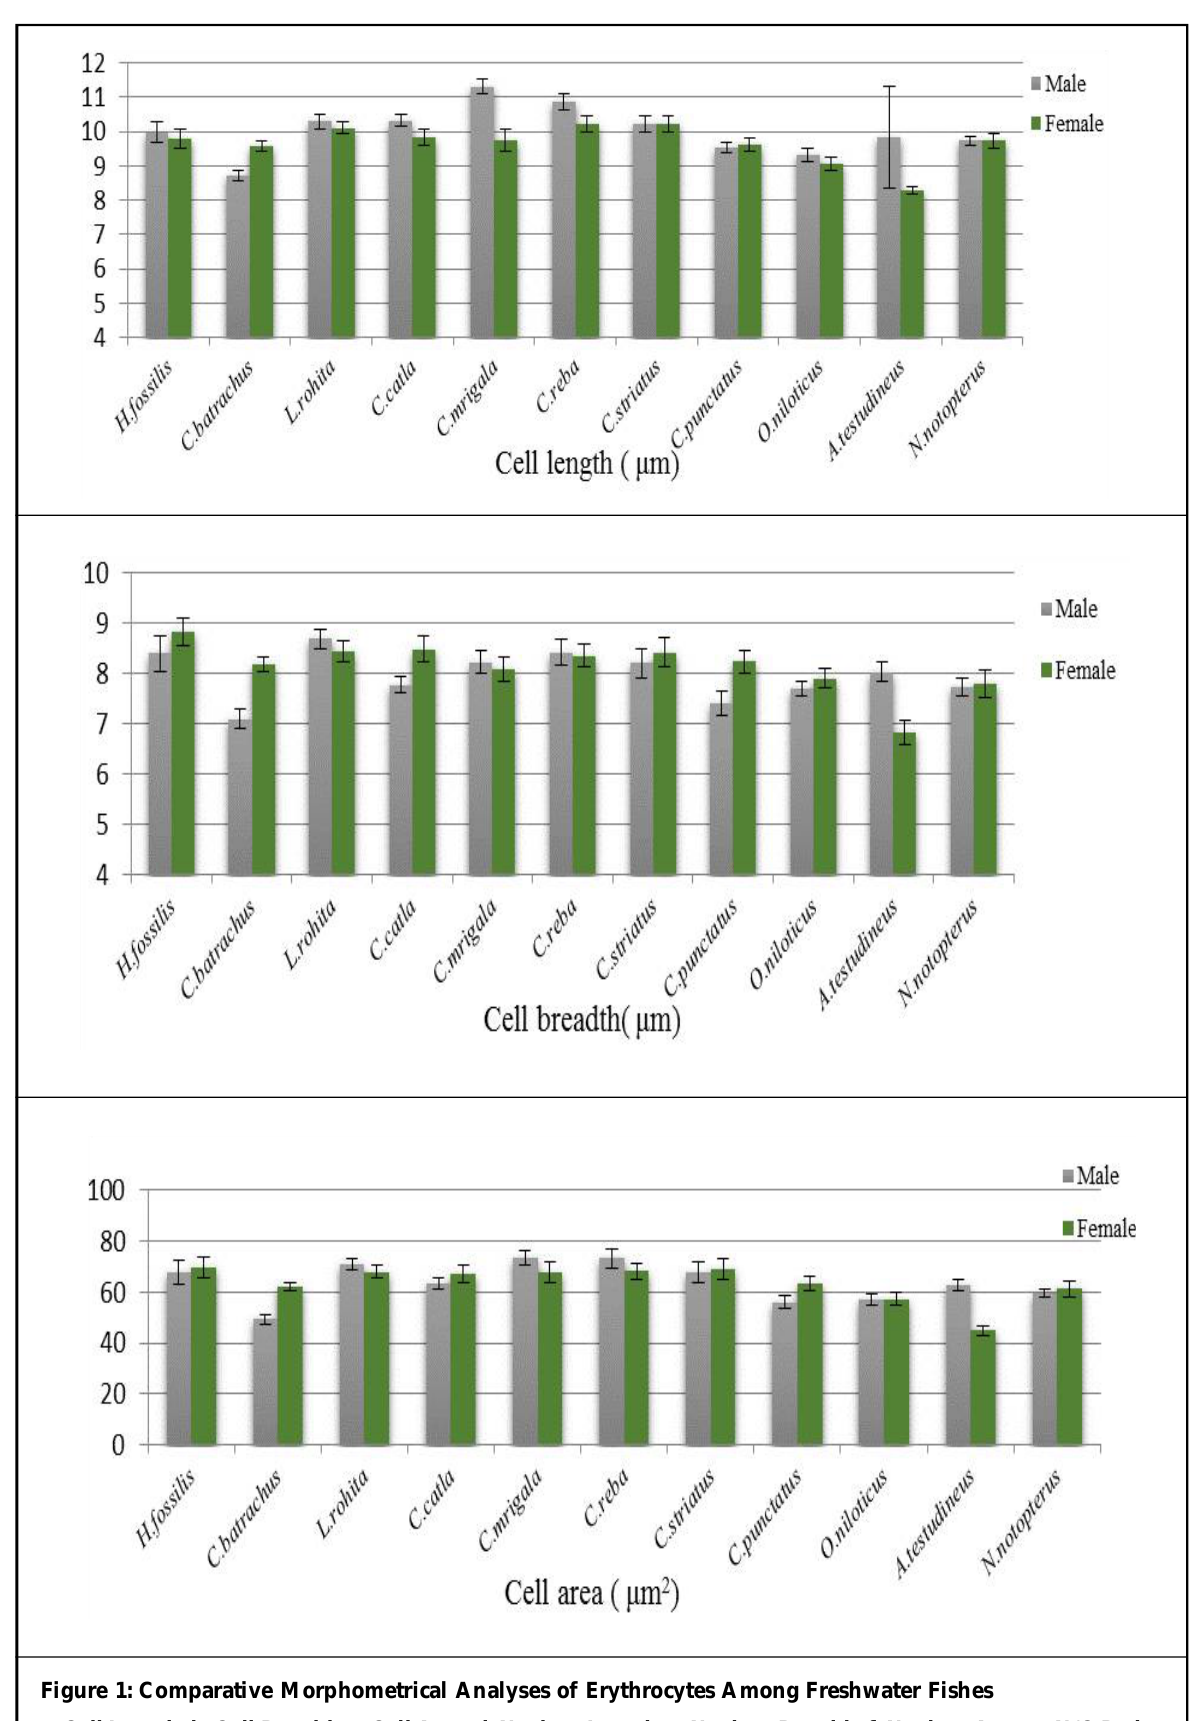
Figure 1: Comparative Morphometrical Analyses of Erythrocytes Among Freshwater Fishes a. Cell Length, b. Cell Breadth, c. Cell Area, d. Nucleus Length, e. Nucleus Breadth, f. Nucleus Area, g. N/C